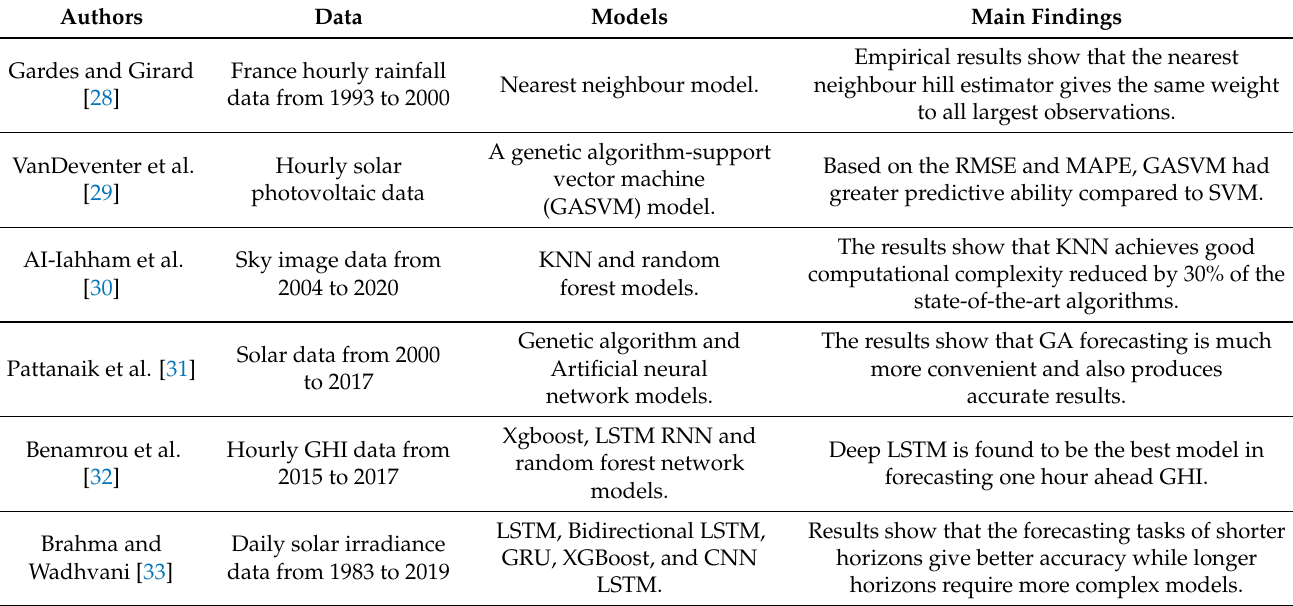
Table 1. Summary of some previous studies on modelling and forecasting solar irradiance using GA, RNN, and KNN. Authors Data Models Main